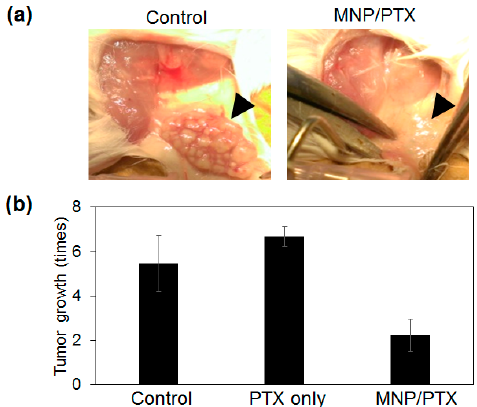
Figure 8. ( a ) Photographs of tumors after the treatment with (right) and without (left) fiber. ( b ) Tumor growth ratio after the treatment with fiber containing PTX and MNP/PTX.